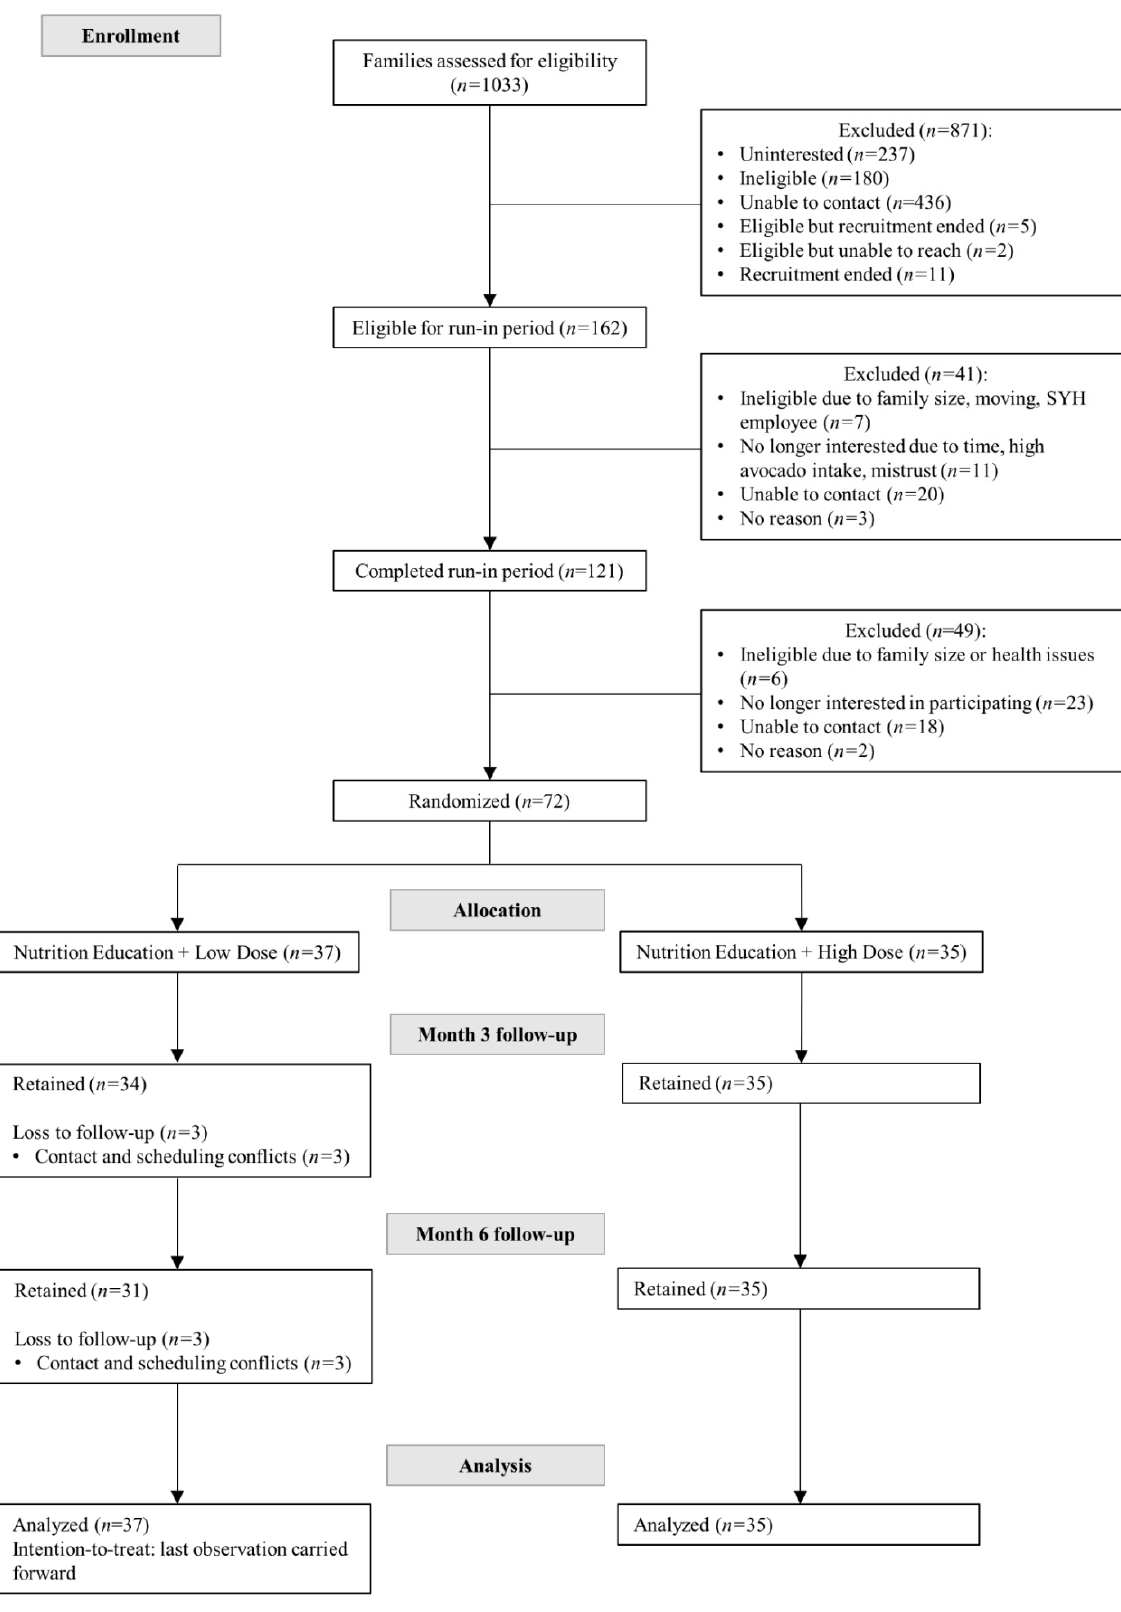
Figure 1. Consolidated standards of reporting trials (CONSORT) flow diagram of the Effects of Avocado Intake on the Nutritional Status of Families Trial.